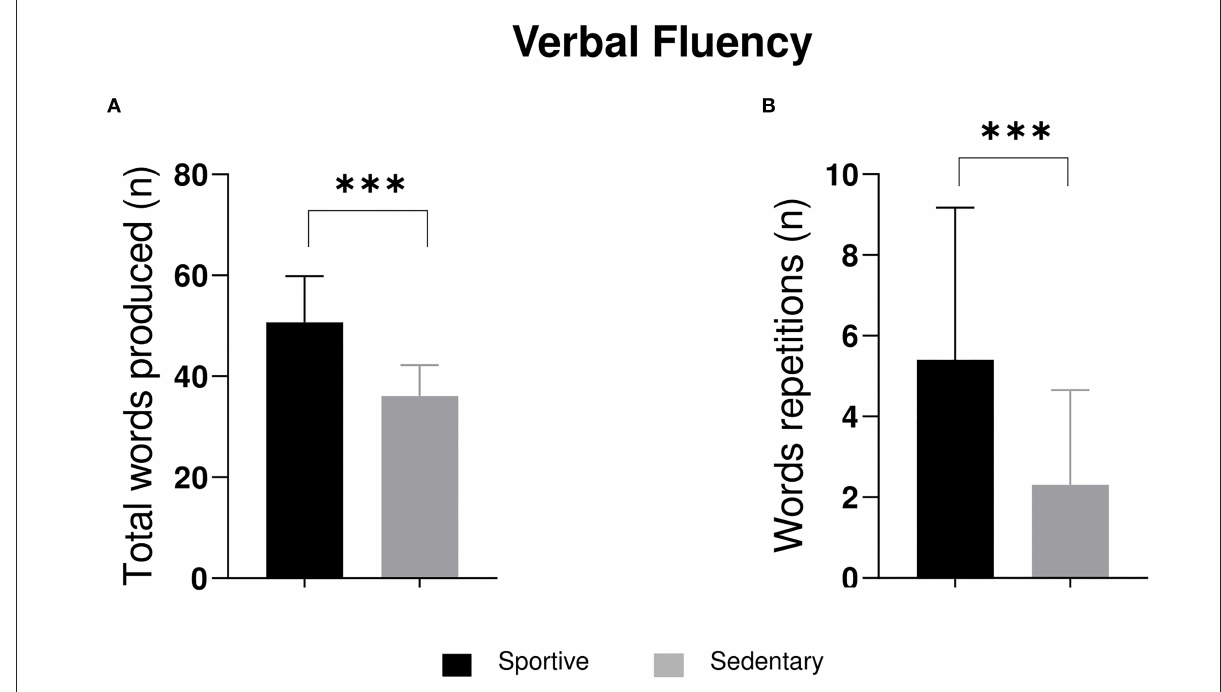
FIGURE1 The 2 × 2 ANOVA significant outputs on (A) total words produced and (B) words repetitions. *** p ≤ 0.001.